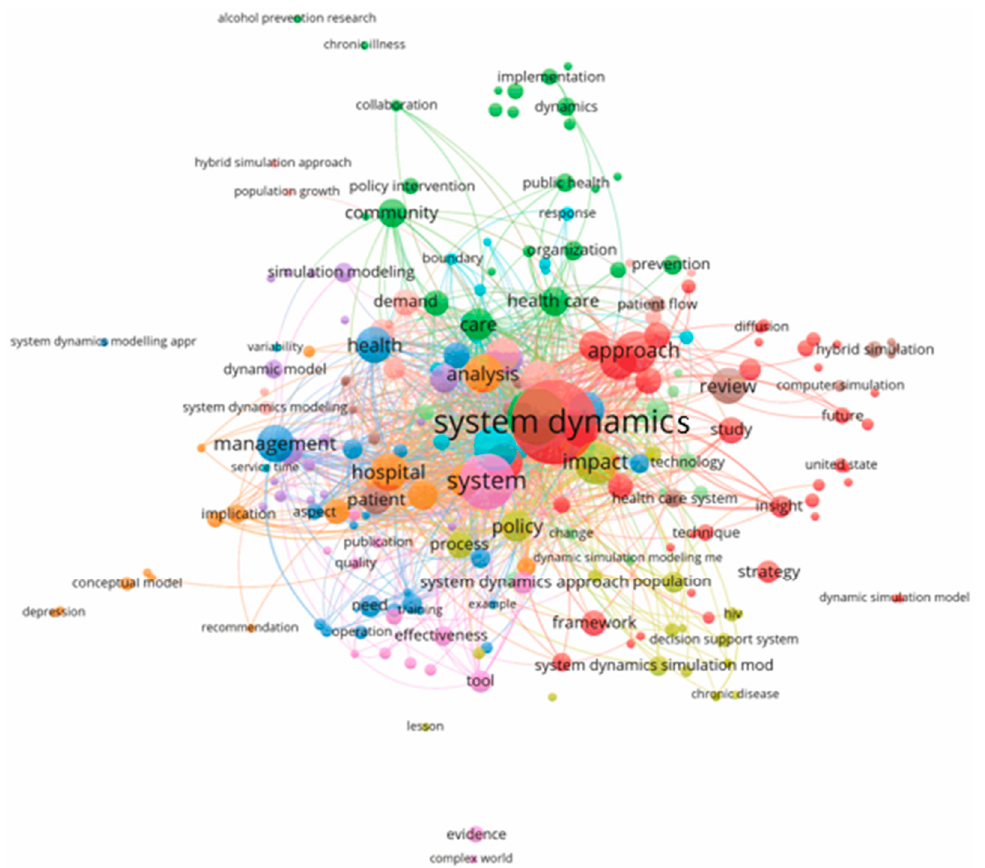
Figure 12. The map of the co-occurrence of terms in titles and abstracts of included papers.